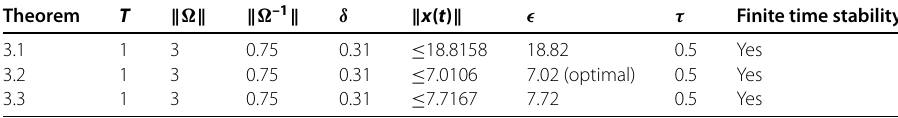
Table 1 Finite time stable results of (23) by Theorems